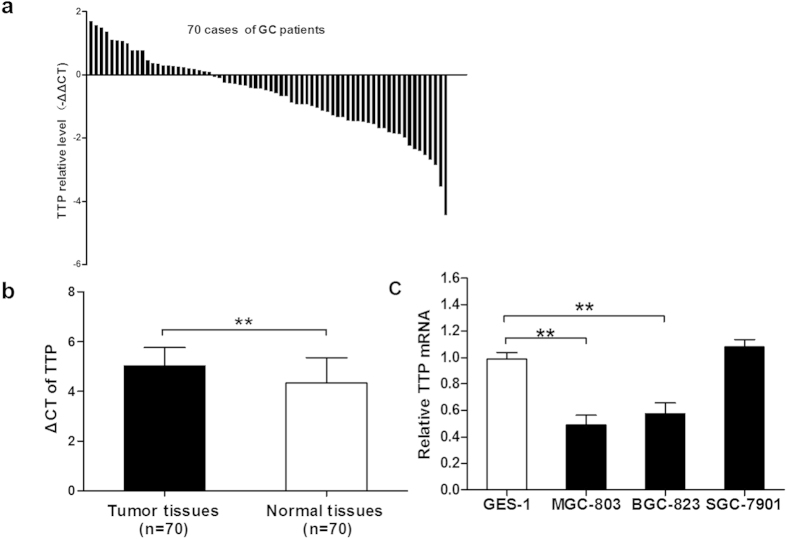
The expression of TTP in gastric cancer tissues and cell lines.(a) Relative expression of TTP mRNA in gastric cancer tissues and their corresponding normal tissues was determined by qRT-PCR and expressed as –ΔΔCT. Down-regulation of TTP was found in 65.7% (46/70) of the selected patients. (b) Results of qRT-PCR showed that the level of TTP mRNA in tumor tissues was significantly lower than levels in adjacent normal tissues. (c) Relative expression of TTP between three gastric cancer cell lines (MGC-803, BGC-823 and SGC-7901) and a normal gastric epithelial cell line GES-1. All data are represented as the mean ± SD of three independent experiments. **P < 0.01.